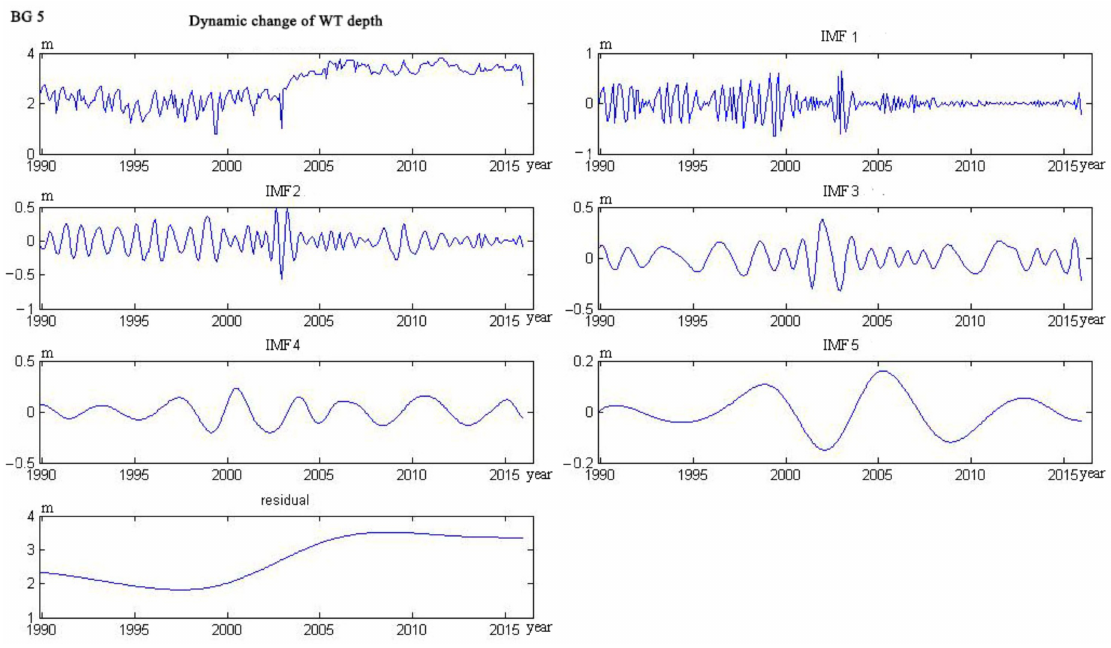
Figure A4. Decomposition of groundwater time series data of well